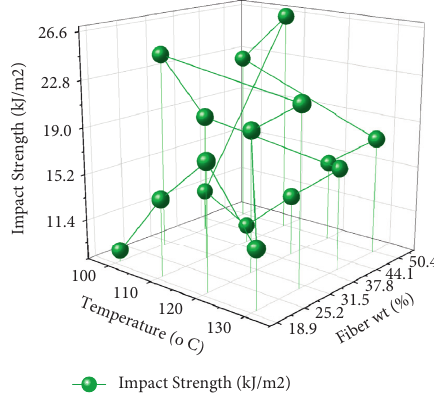
Figure 18: Impact strength: 3D trajectory plot of temperature and fiber weight percentage and